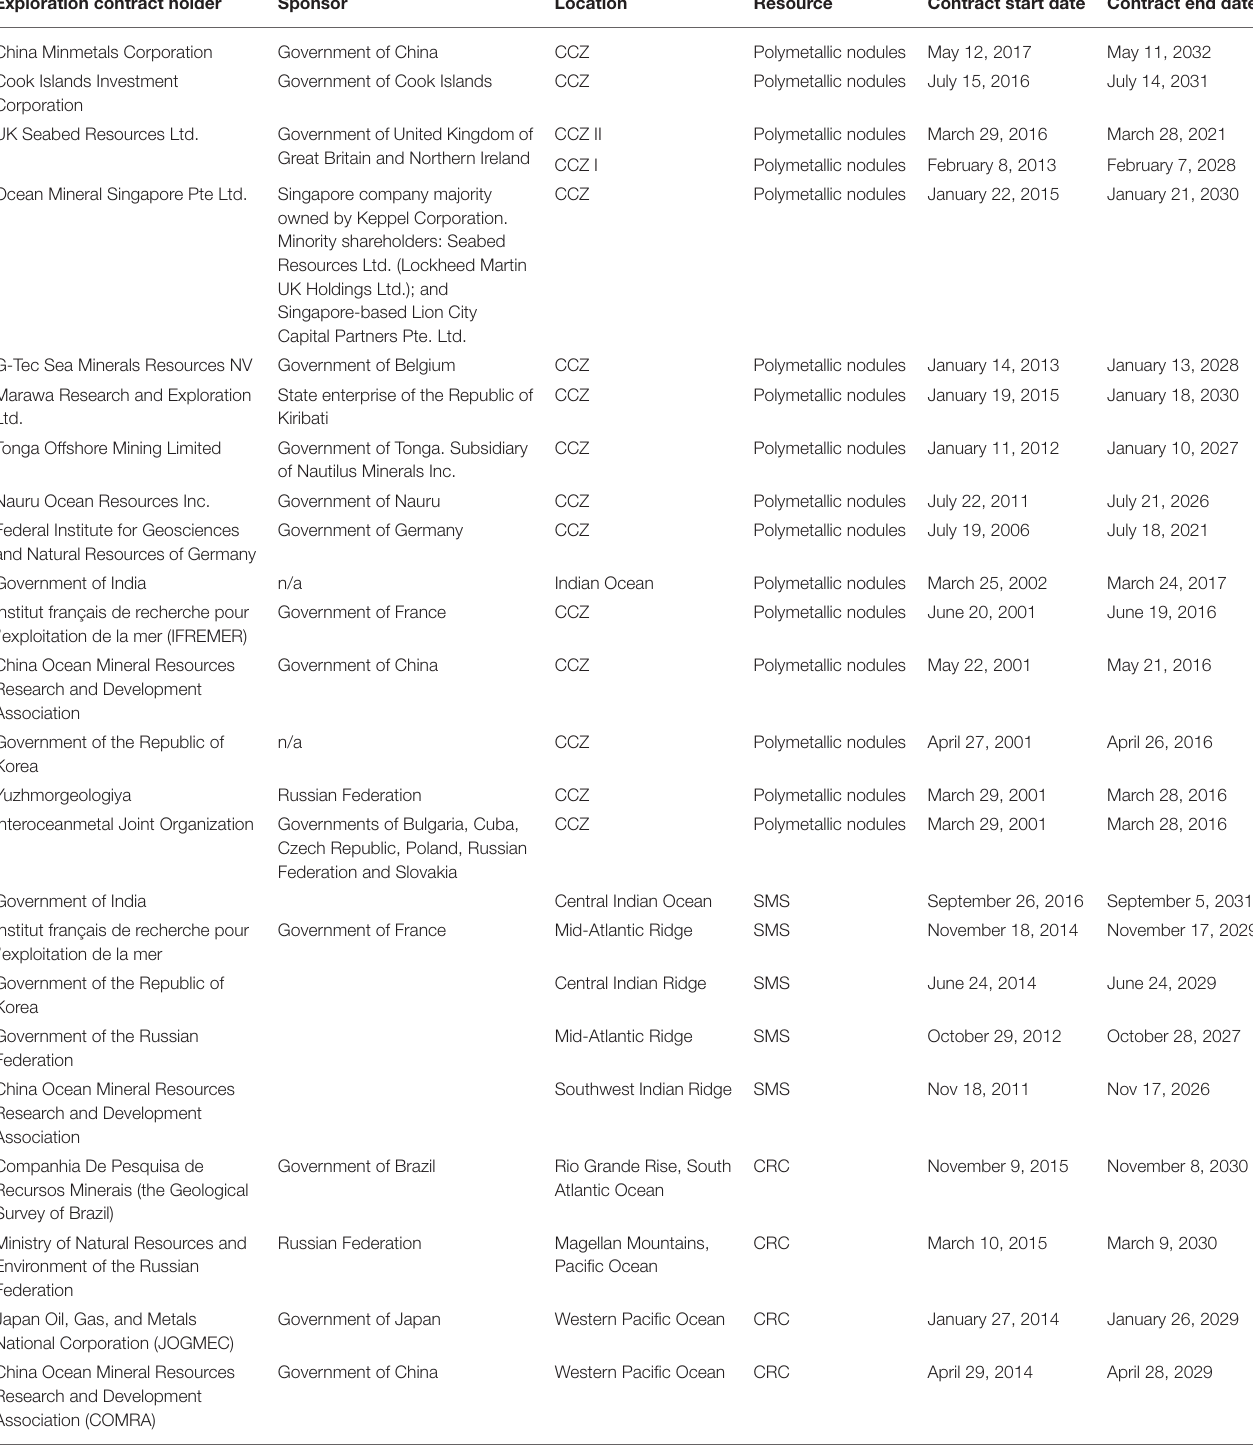
TABLE 2 | A summary of mineral exploration contracts in the Area approved by the ISA as of June 2017 including the start and end dates for these